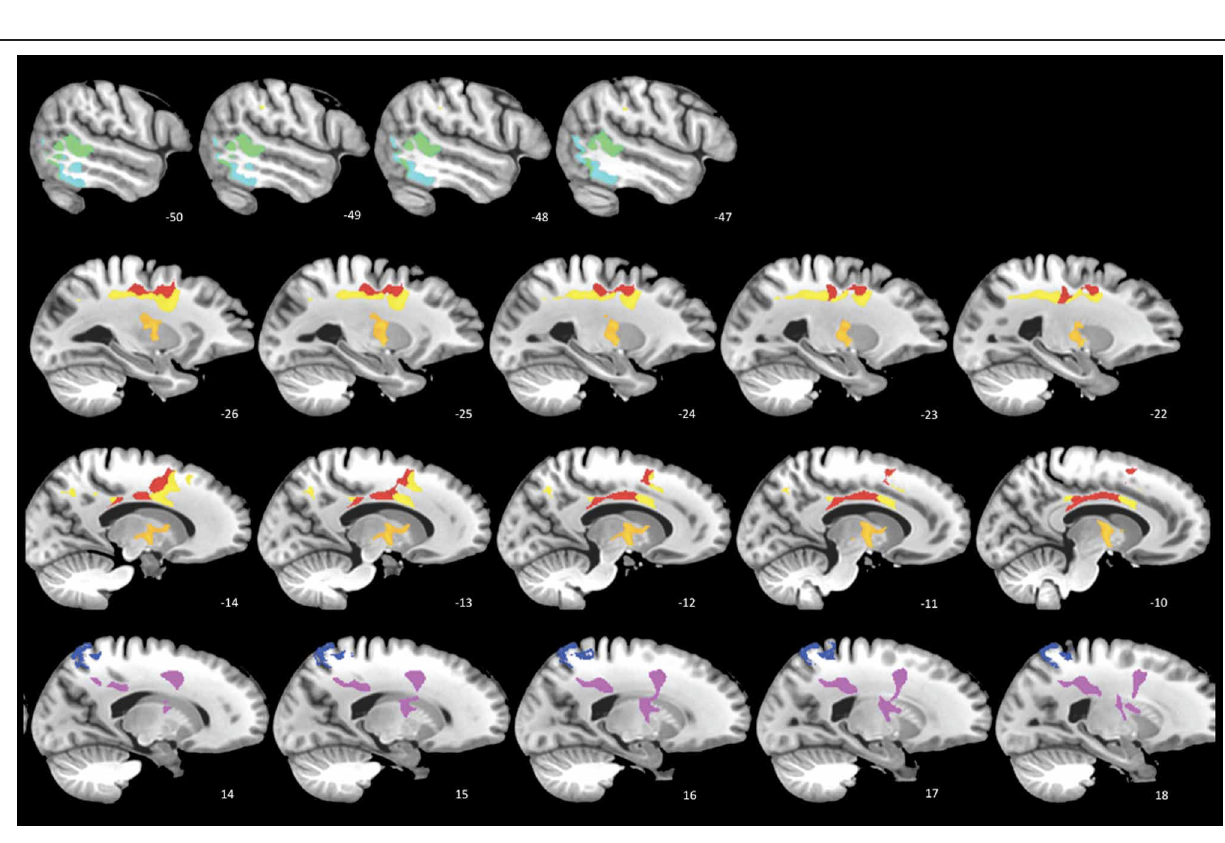
deep gray matter (warm colors) regions includes the thalamus (orange, second row), primary motor tract, and the mid- and posterior bodies of the corpus